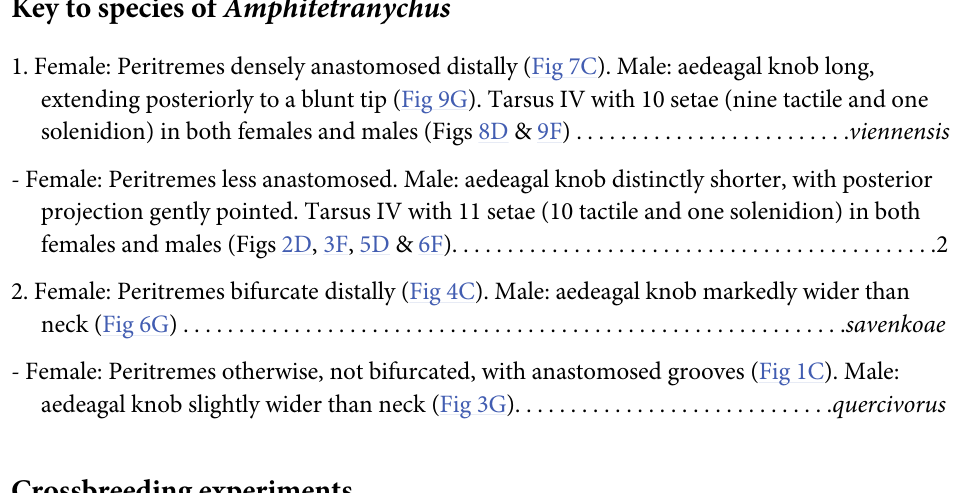
Fig 6. Amphitetranychus savenkoae , male—A. Distal segment of palpus, B. Empodium of leg I, C. Leg I, D. Leg II, E. Leg III, F. Leg IV, G.